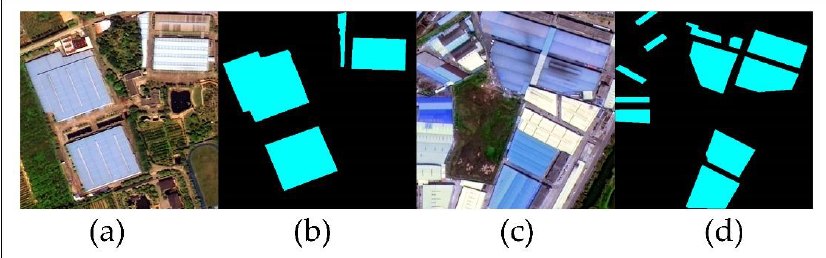
Figure 5. Schematic diagram of digitalized blue steel roofs: ( a ) is the GF-2 image of the sixth region, ( b ) is the digitalized result of the sixth region, ( c ) is the GF-2 image of the tenth region, and ( d ) is the digitalized result of the tenth region.